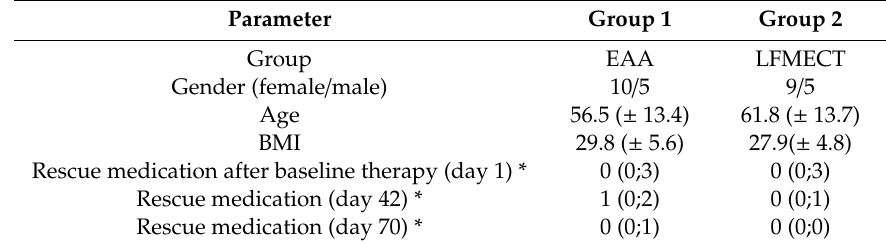
Table 1. Required daily pharmacological rescue medication intake after baseline therapy, at the end of the active study period and at follow-up of all